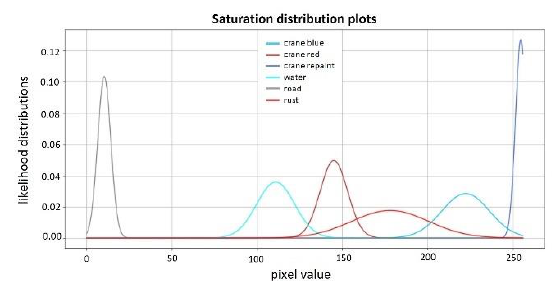
Figure 6. Gaussian distributions of the classes